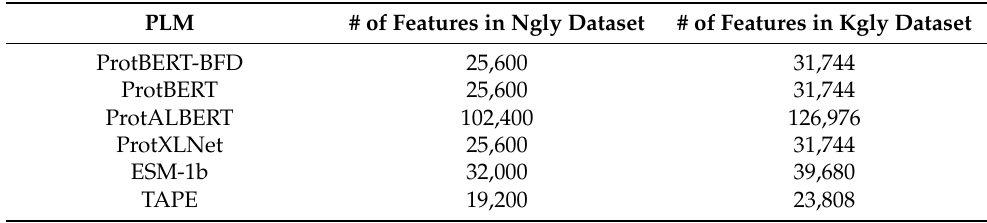
Table 2. The size of embedding features that are extracted for a sample of both Ngly and Kgly datasets based on each used